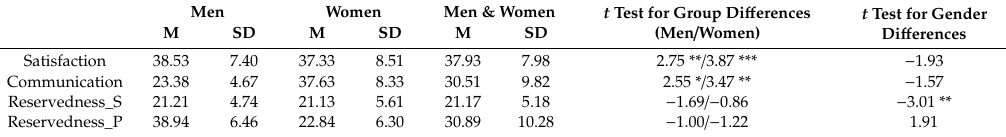
Table 1. Descriptive statistics, the group (infertility and miscarriage) and the gender di ff erences tests. Men